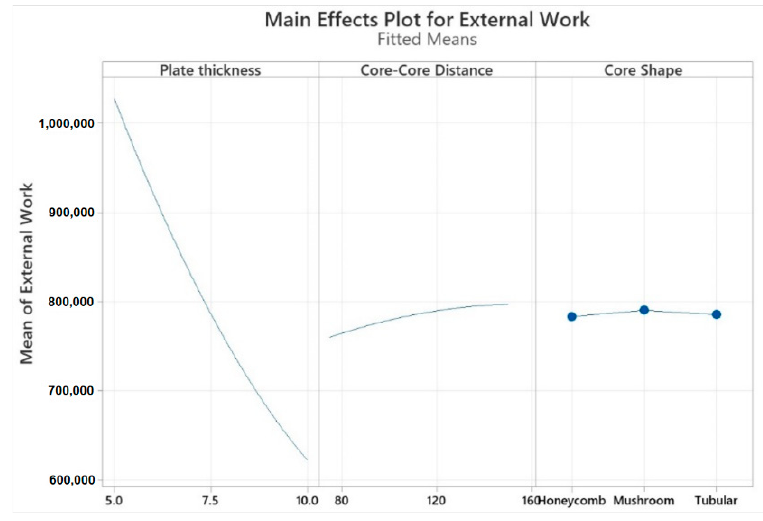
Figure 25. Main effects plot for work done by external force.